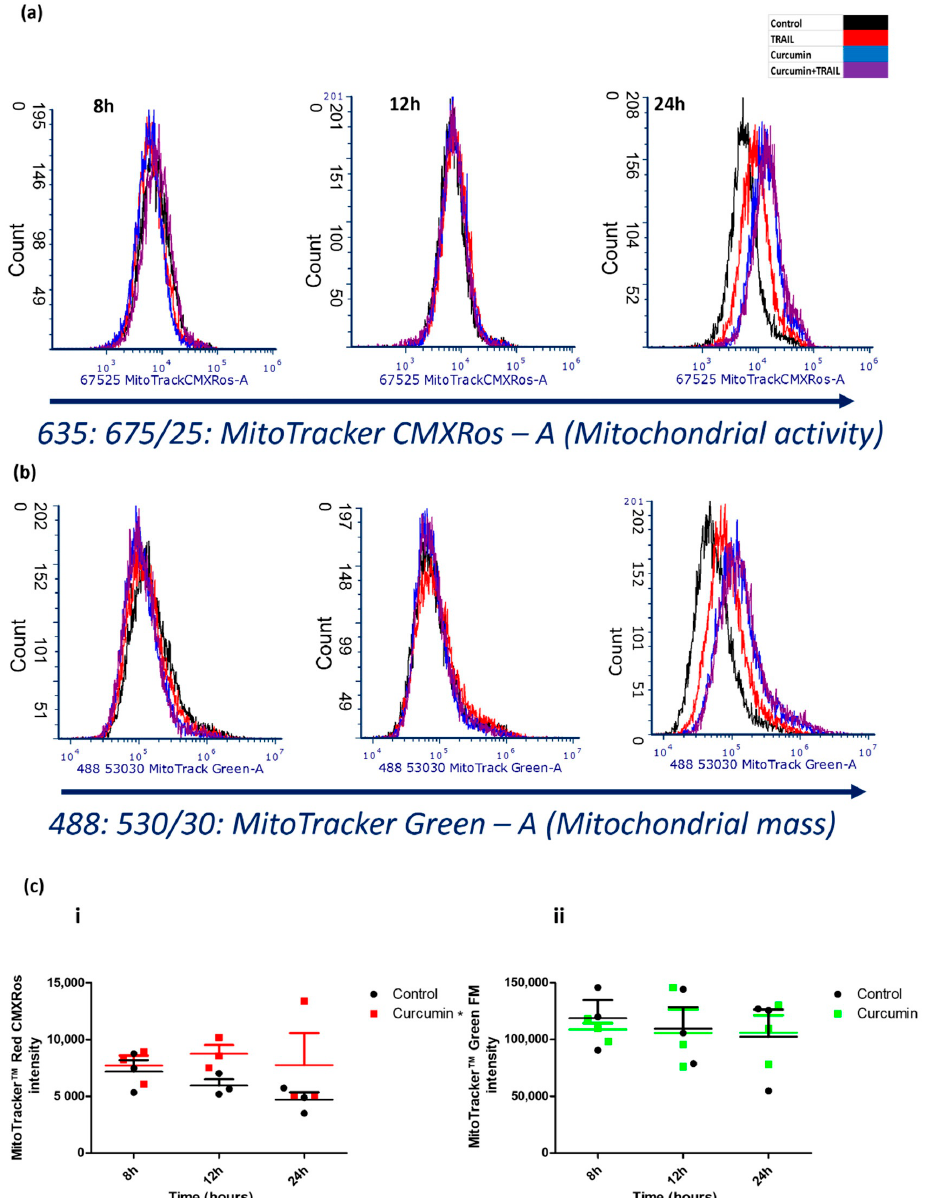
Figure 4. Effect of curcumin on the mitochondrial mass and activity in ACHN cells. MitoTracker Red CMXRos and MitoTracker Green were employed to measure mitochondrial activity and mass using flow cytometry. MitoTracker Red CMXRos was excited with a solid-state red laser (635 nm) and fluorescence emissions were detected using 675/25 nm filter (FL4) while MitoTracker Green was excited with a solid-state blue laser (488 nm) and fluorescence emissions were detected using 530/30 nm filter (FL1). ( a , b ) representative single-parameter overlay histograms after 8, 12, and 24 h, respectively. ( c ) Column scatter chart shows the effect of curcumin on the mitochondrial activity ( i ) and mitochondrial mass ( ii ). The data are presented as mean of fluorescence intensity ± SEM of three independent experiments. * p < 0.05 compared to untreated control. Data were analysed using TWO-WAY